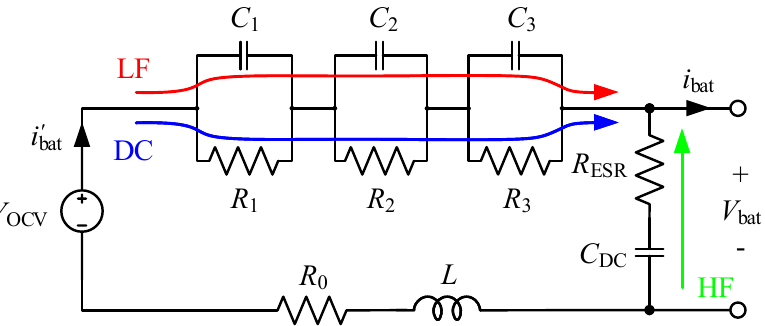
Figure 8. Randles model of a battery pack, using three time constants, including DC